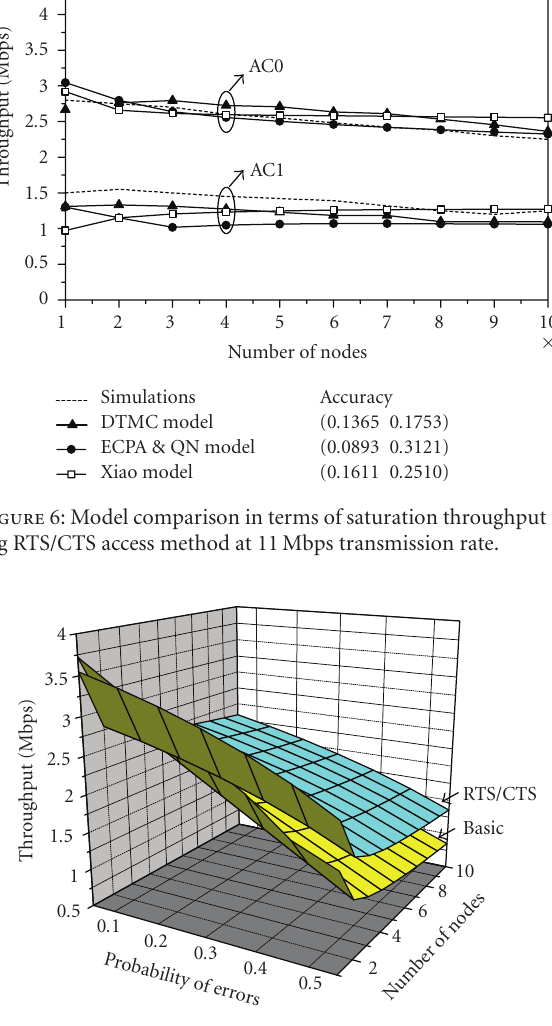
Figure 7: Saturation throughput at 11Mbps, as a function of prob- ability of error and number of stations for